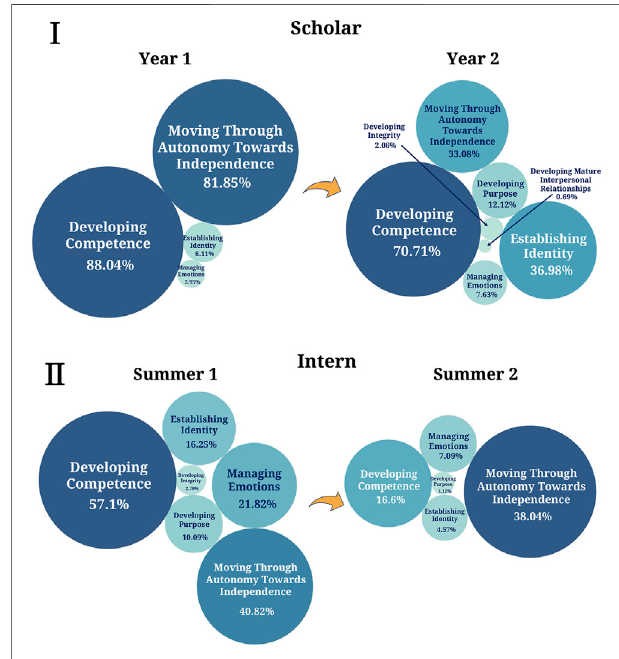
FIGURE 4 | Developing Competence and Moving Through Autonomy Towards Independence are the main Vectors present in Interns (B) and New Scholars [Year 1 of (A) ], represented here by percent coverage (those who have participated in NoyceSCIENCE for < 1 year). However, Vectors like Establishing Identity, Developing Purpose, Managing Emotions, Developing Integrity, and Developing Mature interpersonal Relationships emerge in Veteran Scholars [Year 2 of (A) ; those who have participated in NoyceSCIENCE for > 1